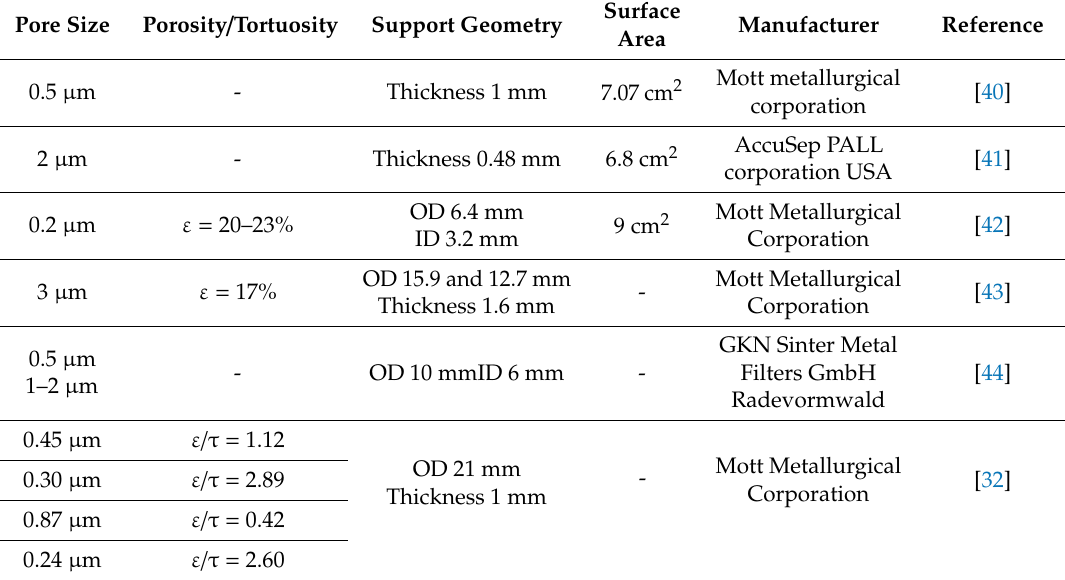
Table 2. Porous metallic support data.